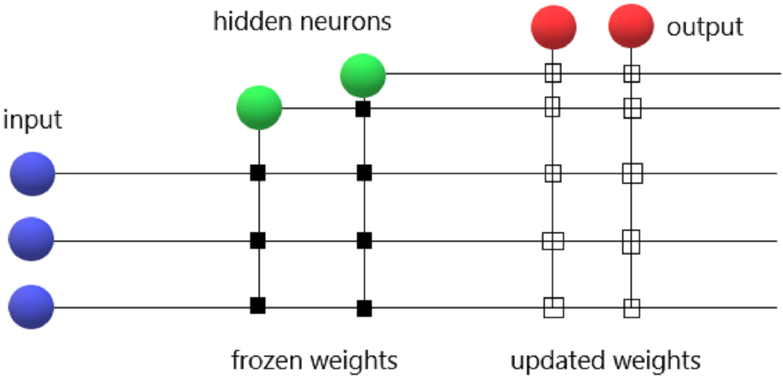
Figure 1. Traditional